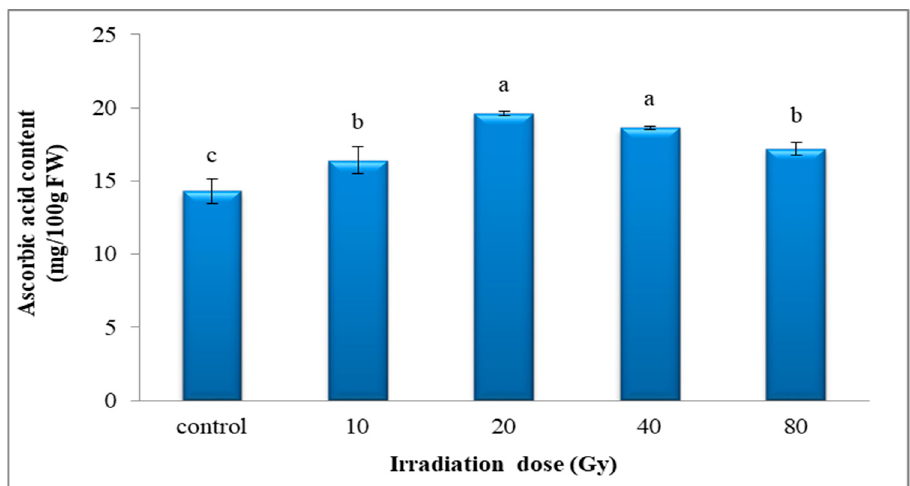
Figure 3. Ascorbic acid content (mg/100 g FW) of red radish roots affected by different doses of gamma-rays. Findings are means ± standard deviations (n = 3). Different letters points to significant differences at p ≤ 0.05, and bars indicate standard deviations.